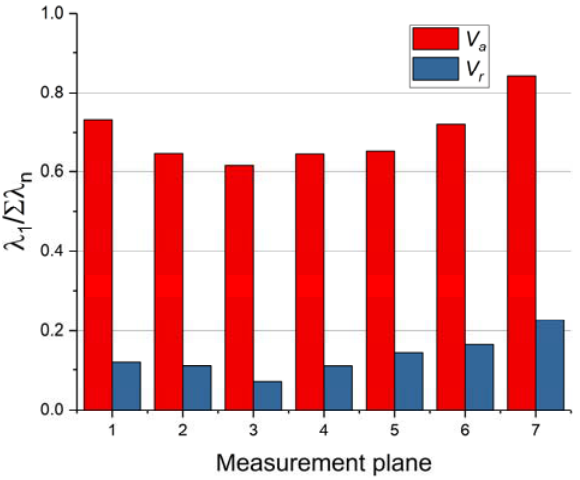
Figure 9. Eigenvalues of the first order proper orthogonal decomposition (POD) mode in different measurement planes in Case 1.